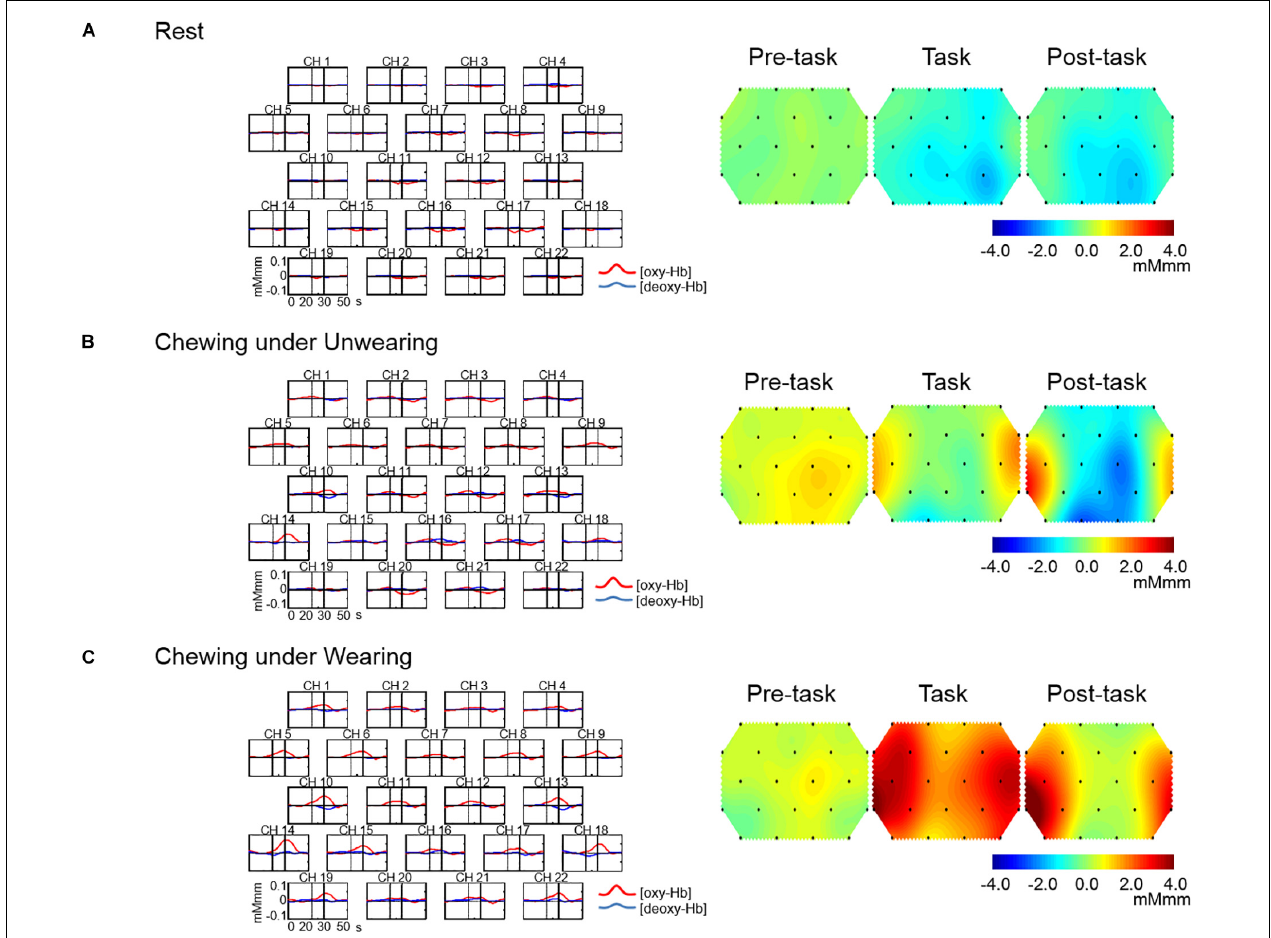
FIGURE 3 | Grand average waveforms for oxygenated hemoglobin concentration [(oxy-Hb)] and deoxygenated hemoglobin concentration [(deoxy-Hb)] and topographical maps showing changes in [oxy-Hb] during Rest and chewing under Unwearing and Wearing conditions. On the left are grand average changes in [oxy-Hb] (red line) and [deoxy-Hb] (blue line) for each of the 22 measurement channels during the Rest condition (A) , chewing under the Unwearing (B) , and Wearing (C) conditions. The x -axis indicates time (s) and the y -axis hemodynamic change (mMmm). Vertical lines at 20 and 30 s indicate the start and end of the 10-s chewing period. On the right are 10-s topographical maps showing changes in [oxy-Hb] preceding (pre-task), during (task), and following (post-task) rest (A) , chewing under the Unwearing (B) , and Wearing (C) conditions. There was little change in [oxy-Hb] throughout the Rest session (A) , while there was a slight increase during the chewing period under the Unwearing (B) condition and marked increases during chewing and post-chewing under the Wearing (C)